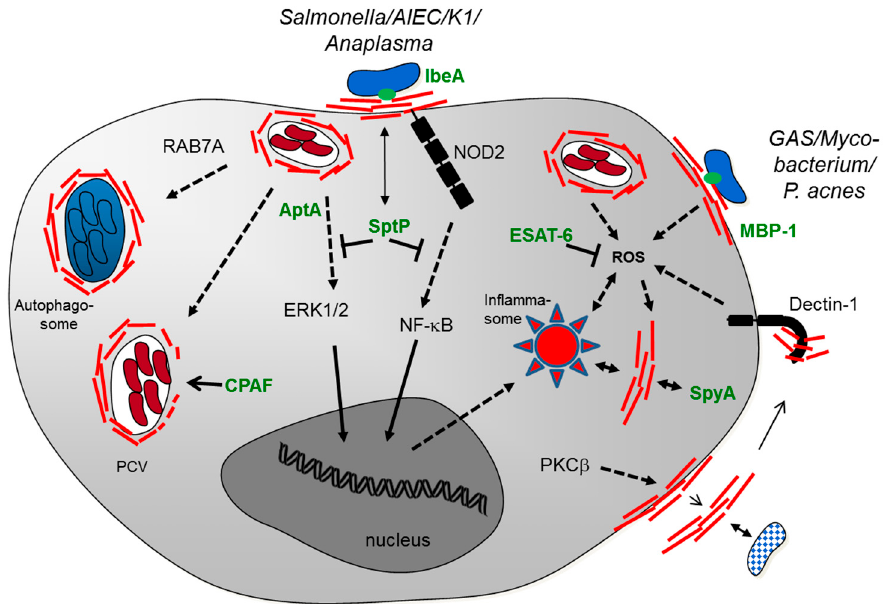
Figure 1. Tentative scheme of the cellular interactions of vimentin with bacterial pathogens. Cell surface-located vimentin (red lines) is involved in binding of the pathogen and subsequent invasion. A variety of intracellular vimentin-pathogen interactions is depicted, mainly occurring in human or murine macrophages. Cytosolic vimentin (red lines) is closely associated to the pathogen-containing vacuole (PCV) and to the autophagosome. The interaction of vimentin with innate immune signaling involves the pattern recognition receptors dectin-1, NOD2, and NLPR3 (inflammasome). PPR-mediated innate signaling further results in activation of MAP kinases (ERK1/2) and NF- κ B. Pathogen-triggered intracellular reactive oxygen species (ROS) production is associated with vimentin upregulation. A few bacterial factors have so far been identified that can mediate vimentin binding (IbeA, MBP-1) or interfere with vimentin functionality (SptP, SpyA, CPAF, AptA; see Table 1 for their origin), possibly by proteolysis or post-translational modification of vimentin. Phosphorylation of vimentin is associated with vimentin secretion that might be involved in pathogen trapping and killing (indicated in bottom right hand corner). Further abbreviations: AIEC, adherent-invasive E. coli ; K1, E. coli K1; GAS, Group